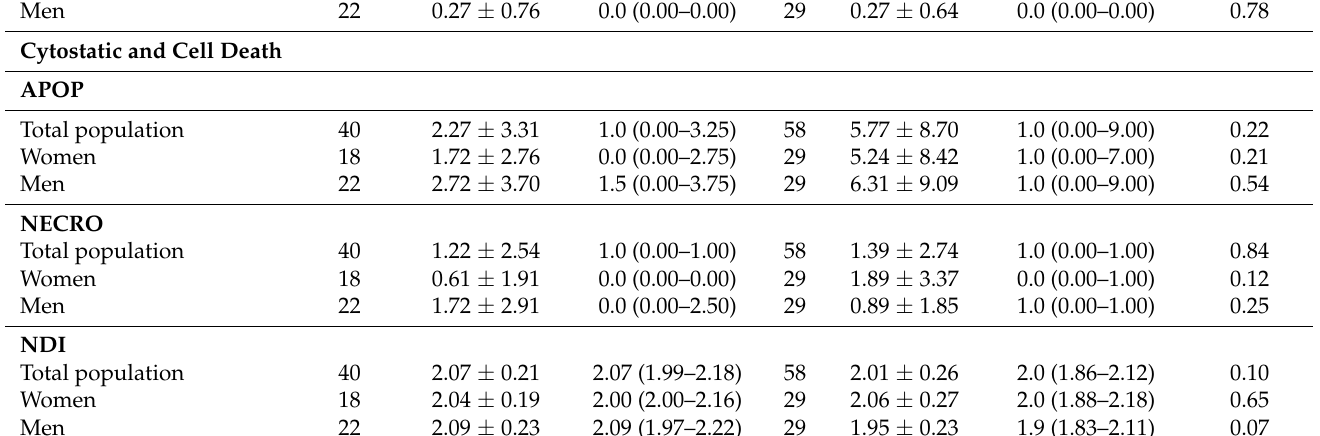
Bold text indicates statistically significant values. SD: standard deviation. a Significant association in comparison to men with the same exposure status. b Significant association in comparison to individuals from